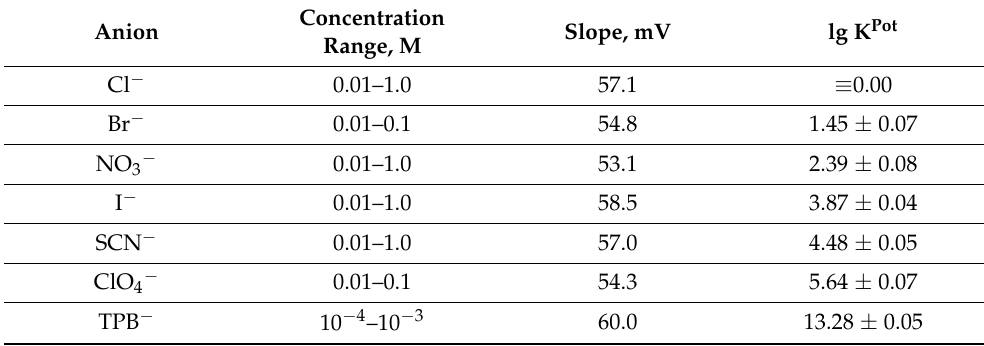
Table A7. The selectivity coefficients for anions (primary ion is chloride-anion), slopes, and concen- tration ranges